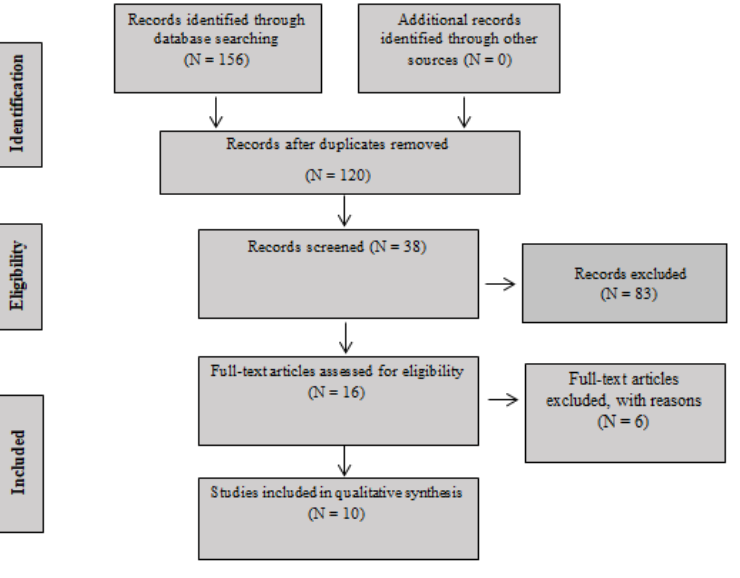
Figure 1. PRISMA Flow Diagram.